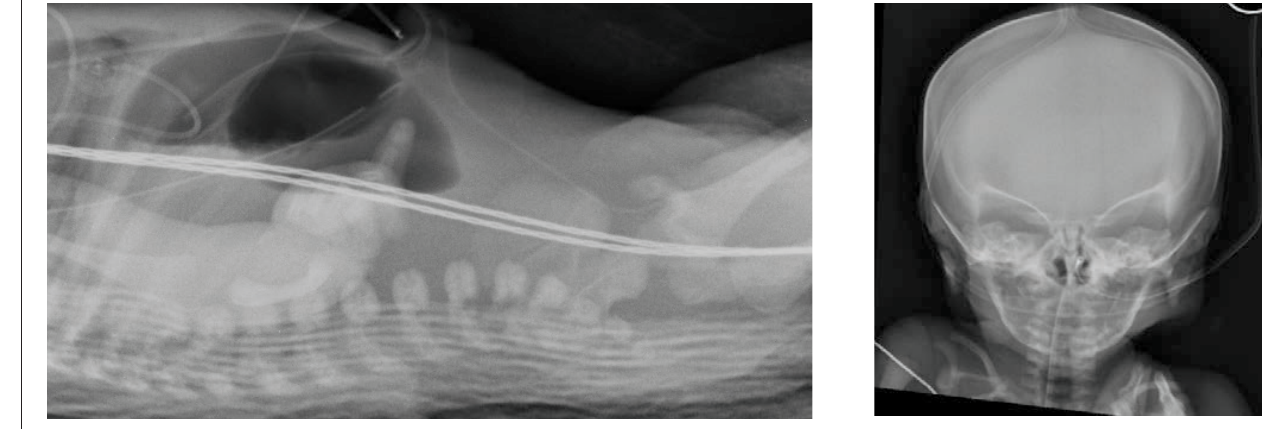
Fig. 2. Portable shoot-through lateral abdominal radiograph.